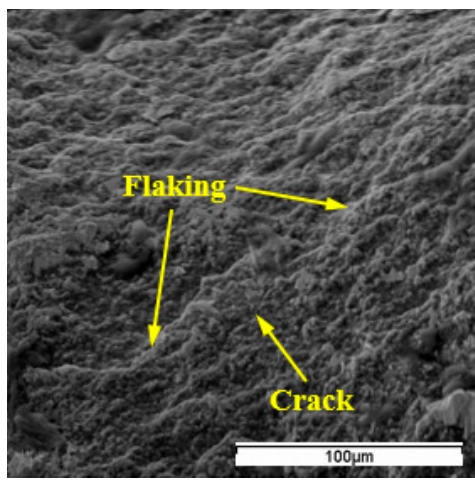
Figure 10. Flaking and cracks at the notching area of SX9.